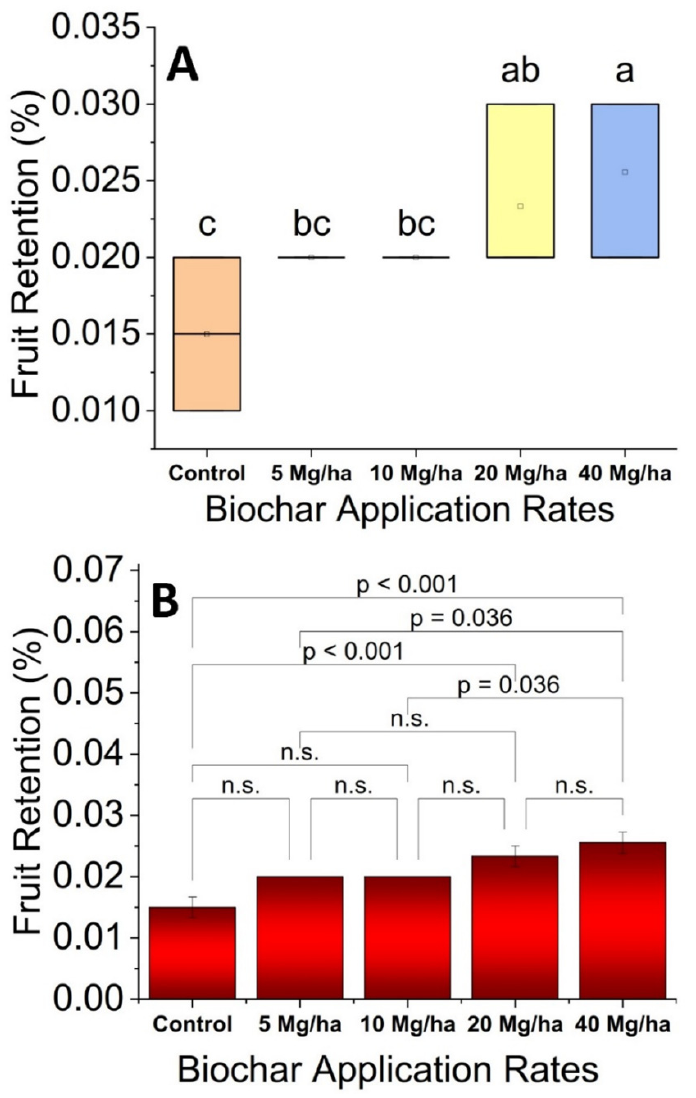
Figure 2. Effect of different biochar application rates on mango fruit retention. Bars are mean of 9 replicates. Different letters show a significant difference at p ≤ 0.05 ( A ). The probability value hierarchy for fruit retention is provided in ( B ).